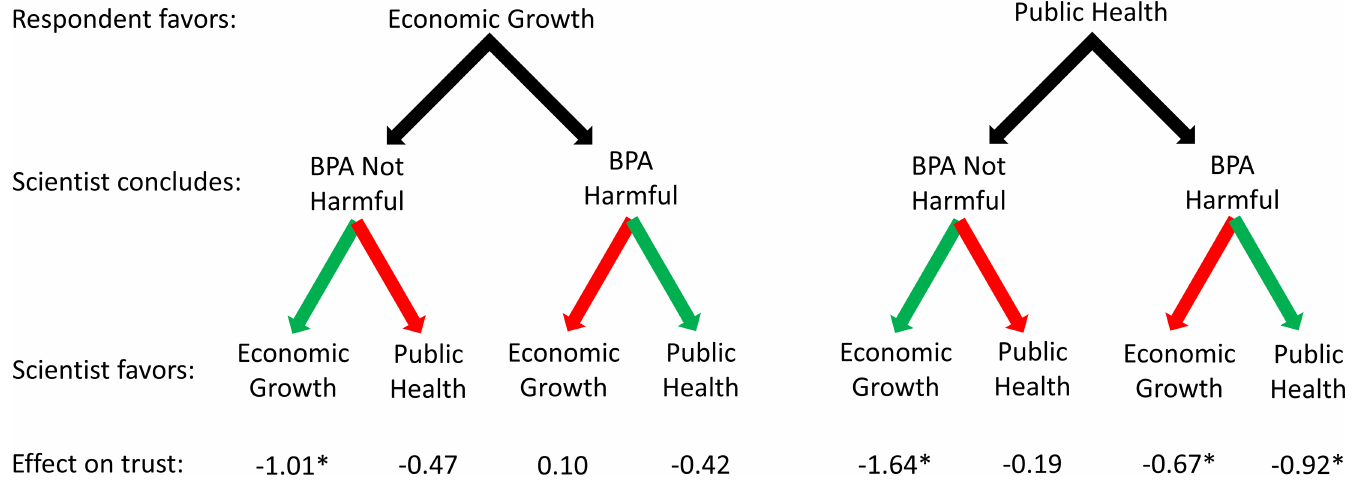
Fig 2. Effects of scientists’ conclusions and expressedvalues on respondents’ trust in them. Effects are relativeto a scientist not expressinga preferencefor particular values and are net of control variables; see Table 1. Green arrows are used when the scientist’s conclusioncoincideswith the scientist’s values; red arrows are used when the scientist’s conclusionconflicts with the scientist’s values.